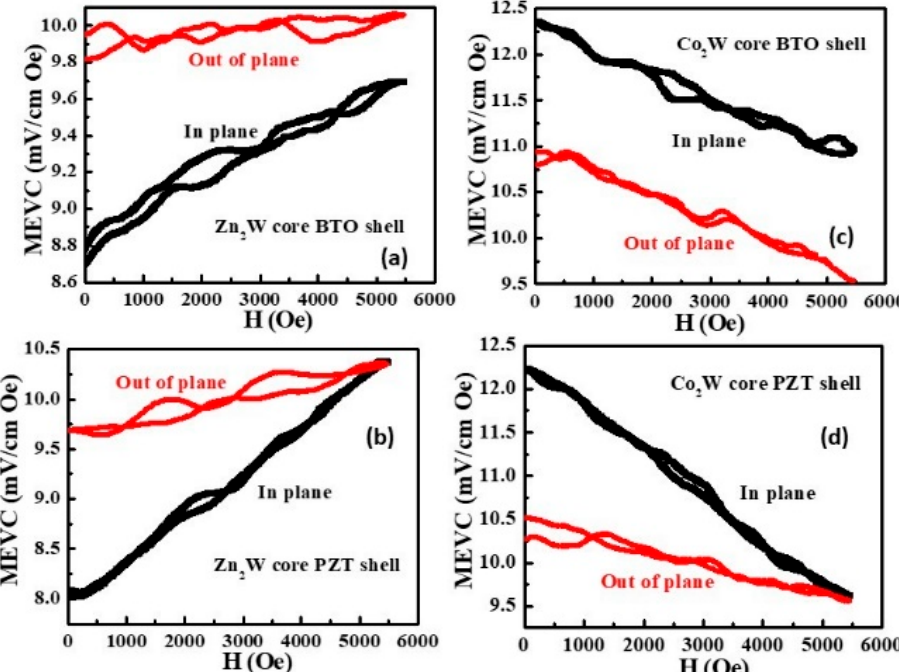
Figure 12. Data as shown in Figure 11 for 3D films with fibers of ( a ) Zn 2 W and BTO, ( b ) Zn 2 W and PZT, ( c ) Co 2 W and BTO, and ( d ) Co 2 W and